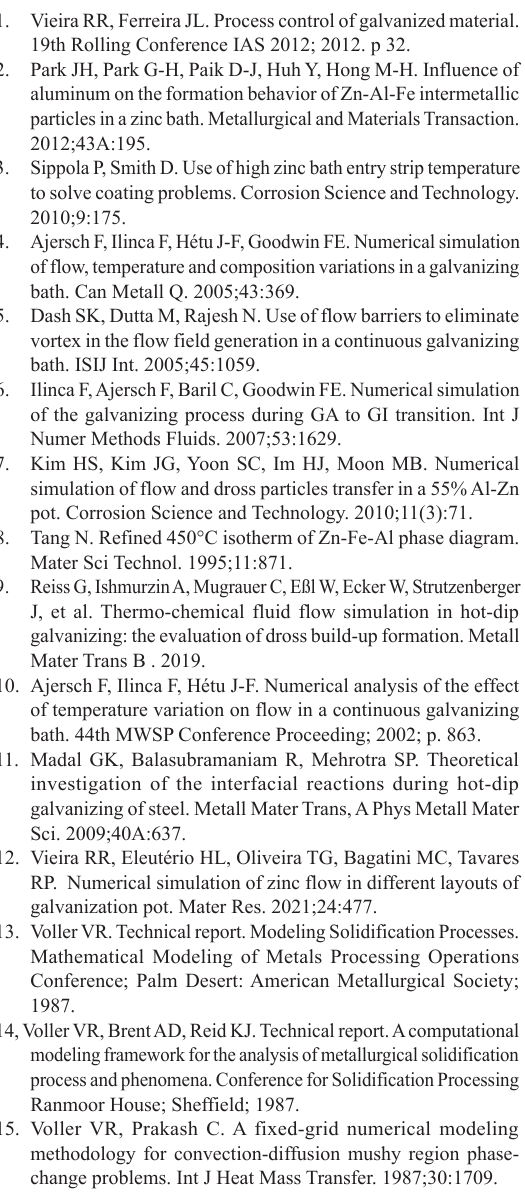
Figure 19. Cross-section aspect of the coating with top-dross particle with 2000X magnification.